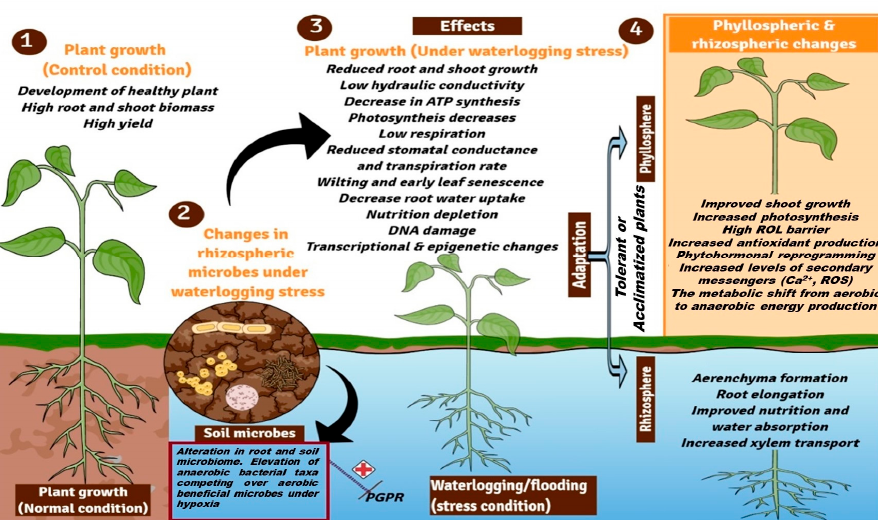
Figure 1. A general overview of the effect of waterlogging stress on sensitive plants and the adaptive mechanisms found in tolerant or acclimatized plants: (1) plant growth at normal/control conditions, (2) changes in rhizospheric microbes such as plant-growth-promoting bacteria (PGPR), (3) effect of waterlogging stress on plant morphophysiological, biochemical, and molecular changes, and (4) adaptation mechanisms in waterlogging-tolerant/acclimatized plants at both phyllospheric and rhizospheric regions in plants during waterlogging stress condition. ROL (radial oxygen loss); ROS (reactive oxygen